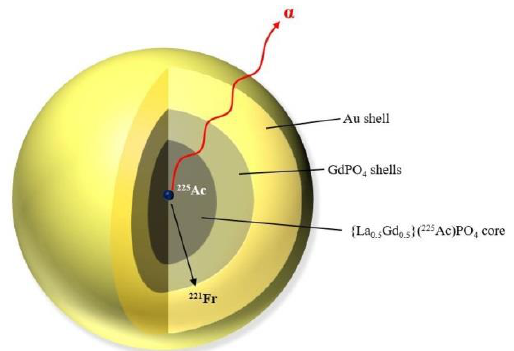
Figure 4. Gold-coated lanthanide gadolinium phosphate nanoparticle (La 0 . 5 Gd 0 . 5 PO 4 @4 shells GdPO 4 @Au) [84].